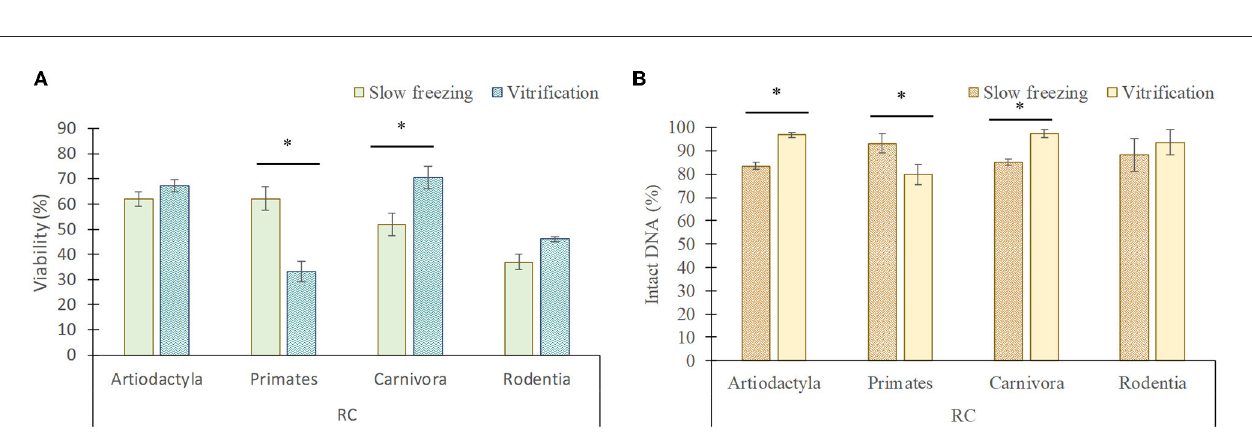
FIGURE7 Viability (A) and DNA integrity (B) of rounded cells (RC; spermatogonia, spermatocytes, early spermatids) in each taxonomic group (mean ± SEM) after slow freezing-thawing and vitrification-warming of testicular tissues. *Indicate differences ( P < 0.05) between cryopreservation methods.